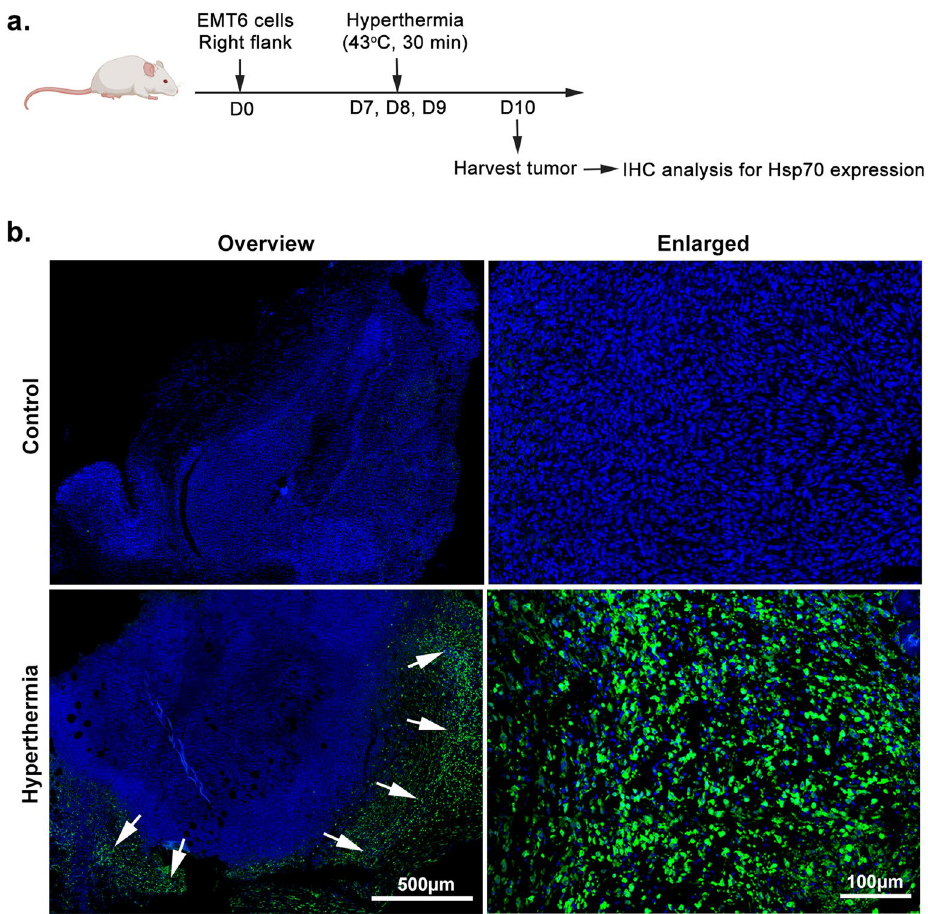
Figure 3. Local hyperthermia by NIR increases tumor Hsp70 expression. Mice were sacrificed 3 days after the first treatment. ( a ) Schematic time course to measure the Hsp70 expression. ( b ) Fluorescence micrograph showing the expression of Hsp70 (shown in green) in tumor. Arrow indicates the area of Hsp70 abundancy. n = 5/6 per